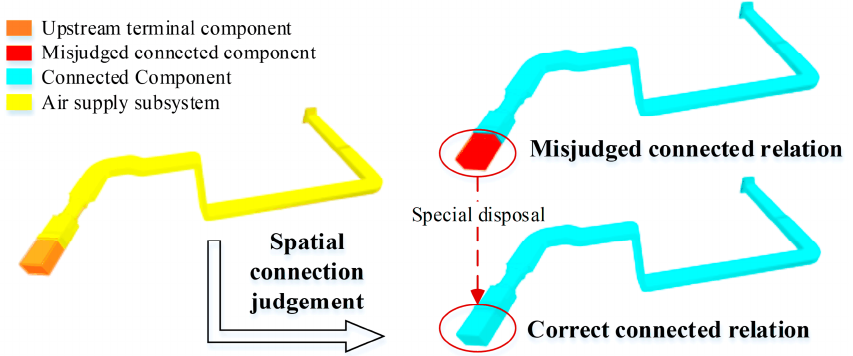
Figure 14. Results of spatial connection judgement within an MEP subsystem.